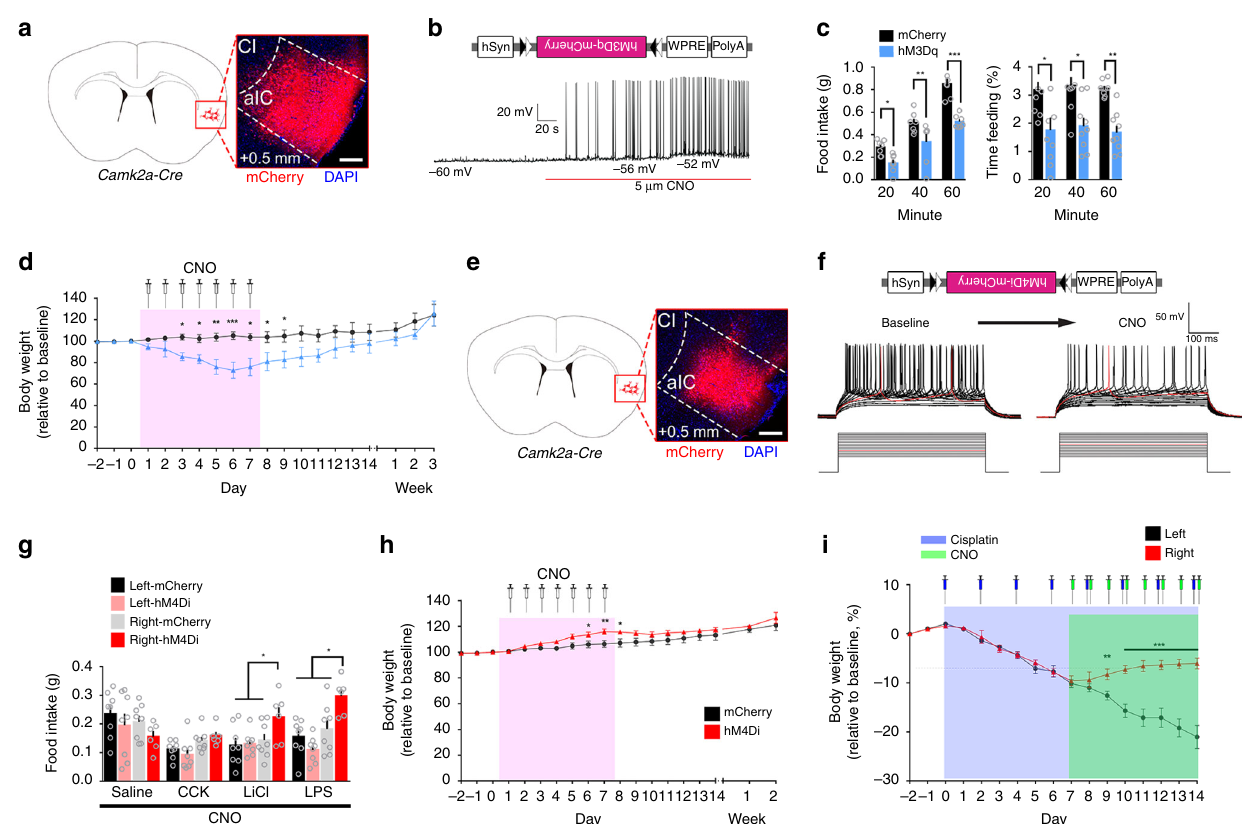
Fig. 5 Inhibition of the right aIC CamKII neurons rescues Cisplatin-induced anorexia. a The inserted image shows the expression of hM3Dq-mCherry in the caudal segment of the right aIC. Scale bar, 250 μ m. b Diagrams illustrating the injected virus (upper) and example current-clamp traces from the brain slice with the right aIC CamKII neurons expressing hM3Dq before and after treatment with CNO. c Food intake (left) and percentage of feeding time (right) in CNO-treated 24 h-fasted mice expressing hM3Dq in the right aIC CamKII neurons during 20, 40, or 60-min test ( n = 7 mice for per group). d Chronic administration of CNO (pink area, 1 mg/kg, every 12 h for 7 days, i.p.) reduces body weight ( n = 8 mice per group). e The inserted image shows the expression of hM3Di-mCherry in the caudal segment of the right aIC. Scale bar, 250 μ m. f Diagrams illustrating the injected virus (upper) and current – voltage relationship of a representative aIC CamKII neuron recorded before and after perfusion with CNO. Raw traces show individual voltage responses to a series of 500 ms current pulses from 100 to 200 pA with 10-pA steps. Red traces indicate the minimal current to induce action